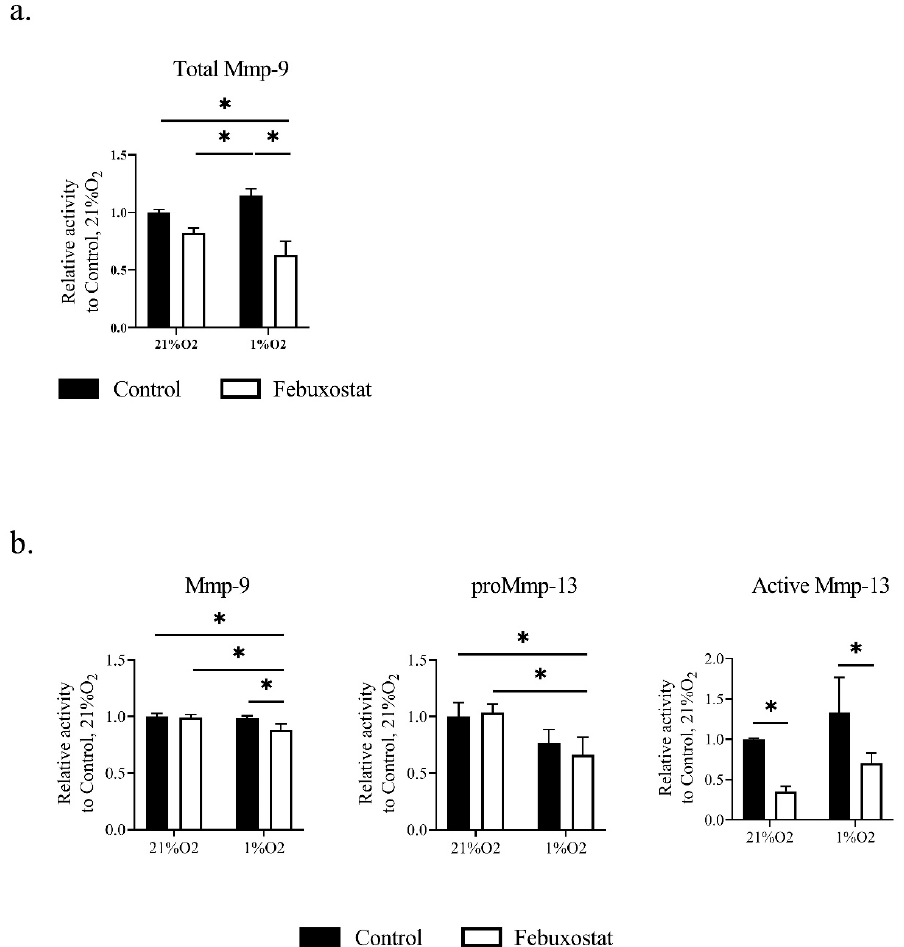
Figure 4. Inhibition of ROS production by XO attenuates gelatinolytic and collagenolytic activity in TEPMs. TEPMs were cultured under normoxic (21% O 2 ) and hypoxic (1% O 2 ) conditions in the presence of DMSO (control) or 50 μ M febuxostat. MMP activity in the supernatants was assayed by in-gel zymography. ( a ) The activities of MMP-9 was assayed by gelatin zymography. ( b ) The activities of MMP-9 and 13 were assayed by collagen zymography. The quantification of MMP activity was performed using a densitometry analytic tool (Supplementary Figure S2). Data are expressed as the means ± SD of three independent experiments. The two-way ANOVA and Tukey’s multiple comparisons test were performed for the statistical analysis. * p <